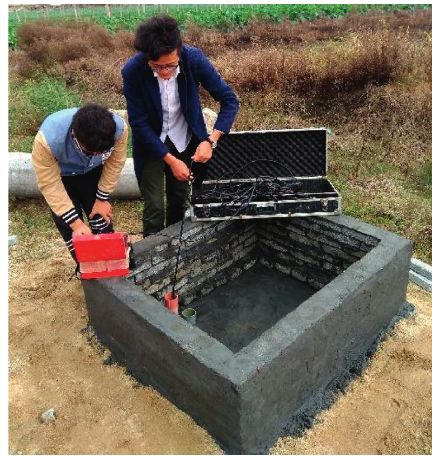
Figure 6: Site data collection. Table 1: Summary of the monitoring sensors in the K53+787 construction